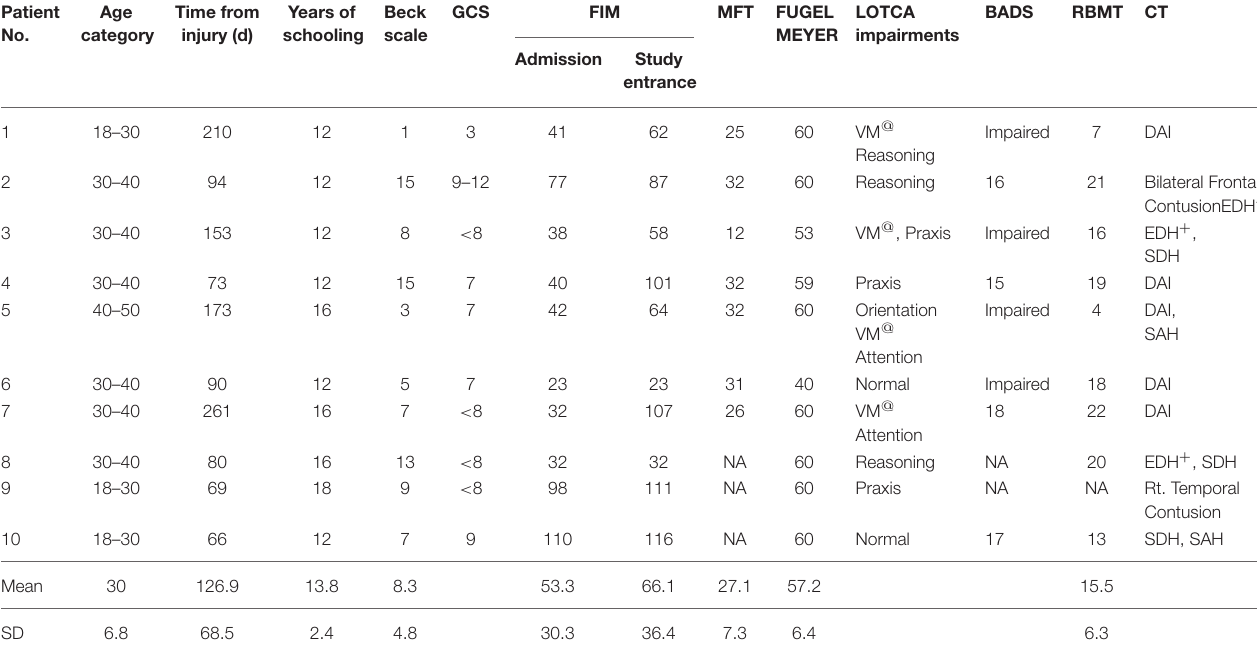
TABLE 1A | Trained TBI group. Patients’ characteristics. Patient No.